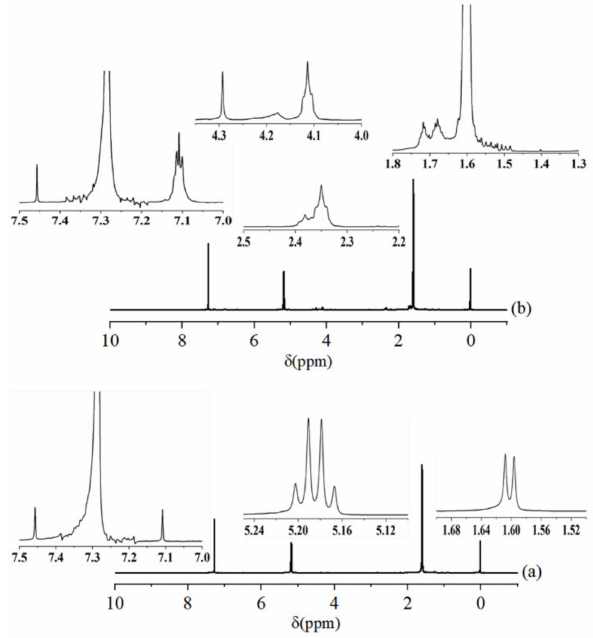
Figure 3. 1 H-NMR spectra of ( a ) PLA and ( b ) purified-PTC.